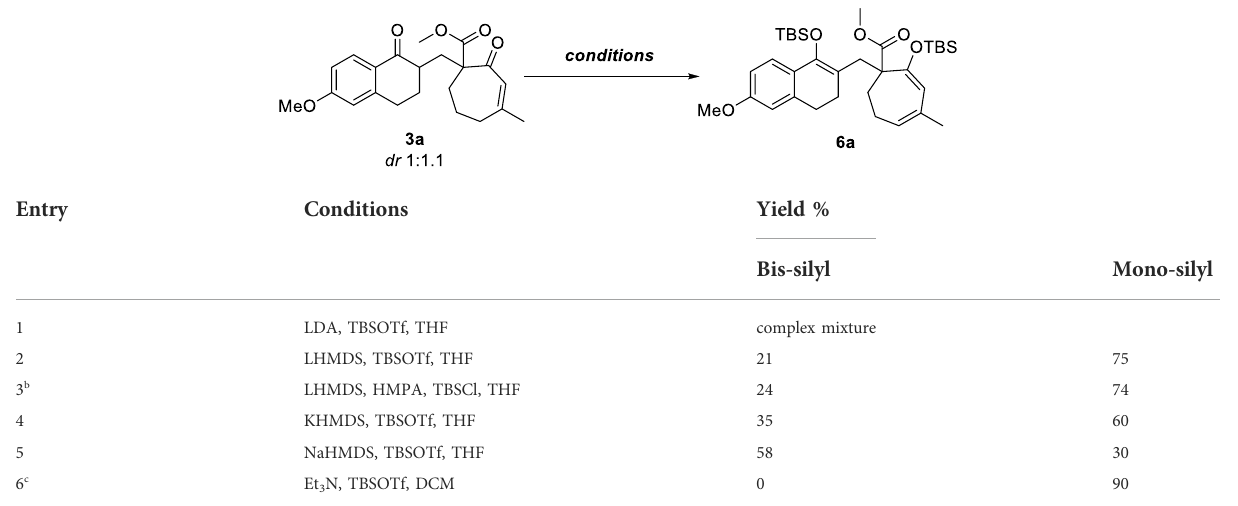
TABLE 2 Optimization of silyl bis-enol etheri fi cation conditions a .